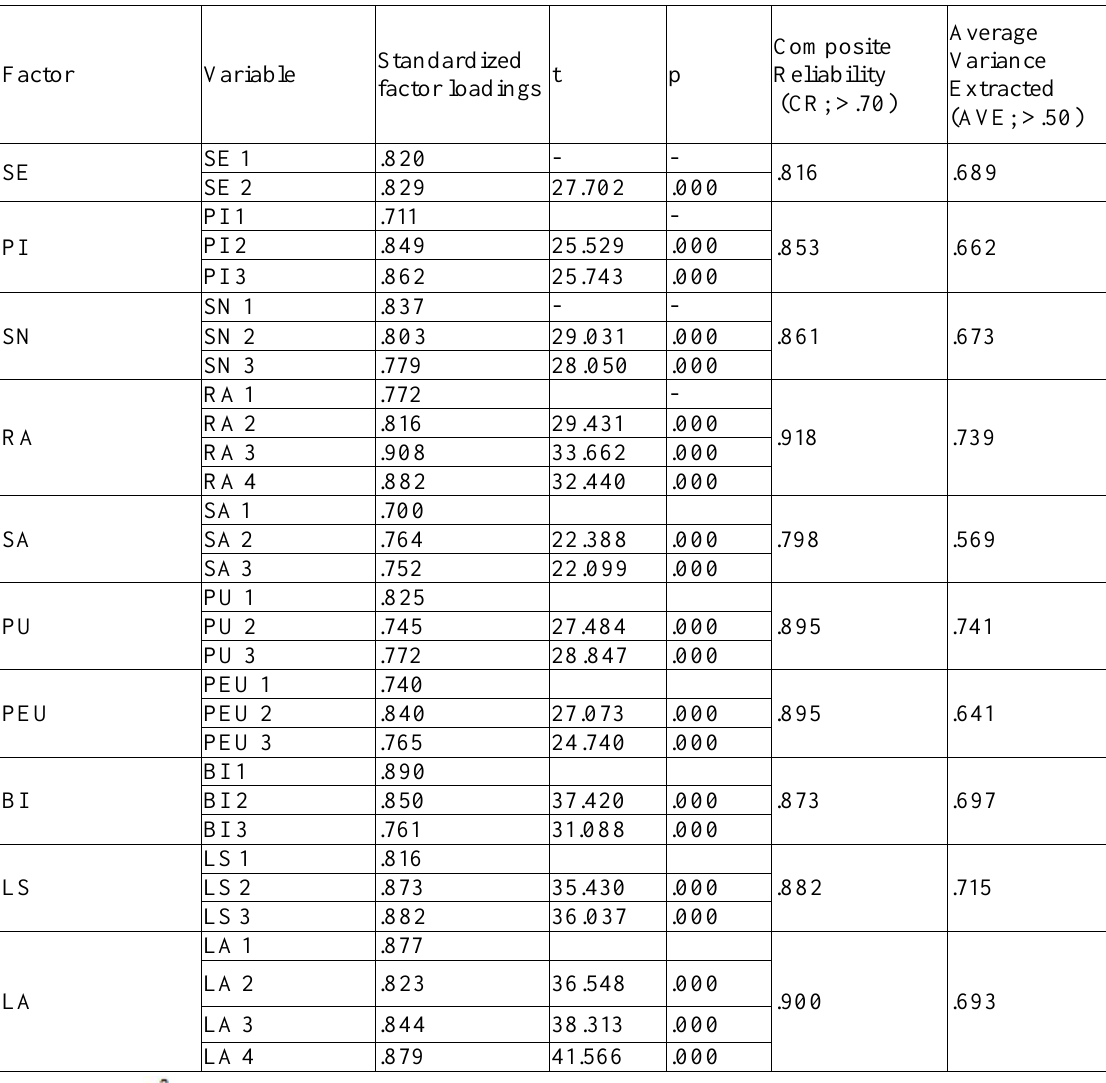
Table 3 Results of Confirmatory Factor Analysis